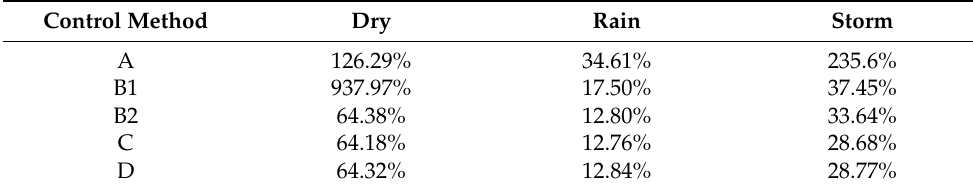
Figure 10. Savings obtained using the RL agent (cumulated difference of Operation Costs). × 100) of the RL agent against each control method Table 3. OC improvement percentage ( final − initial initial from the initial to the final stage (14 days cumulation